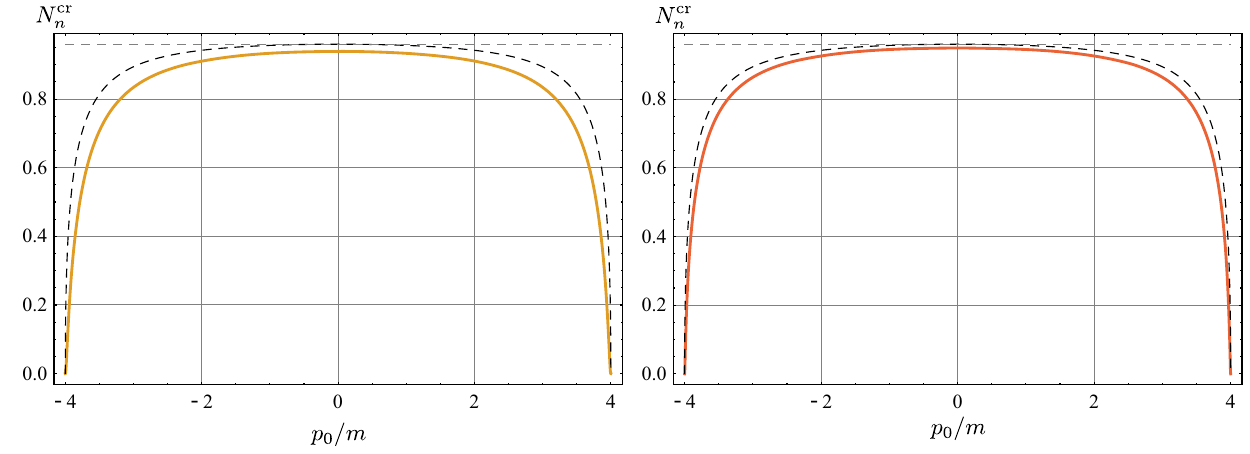
Fig. 3 Differential mean numbers N cr n of Fermions (left panel) and Bosons (right panel) created from the vacuum by symmetrical inverse- square fields (2). The solid lines refer to numerical calculation of the exact expressions (36), (40) while the dashed curves the asymptotic